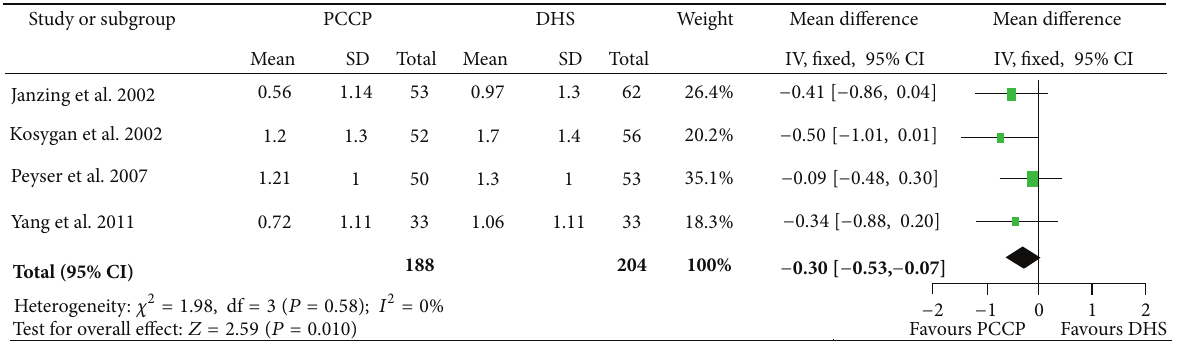
Figure 5: Comparison of transfusion units per person between PCCP and